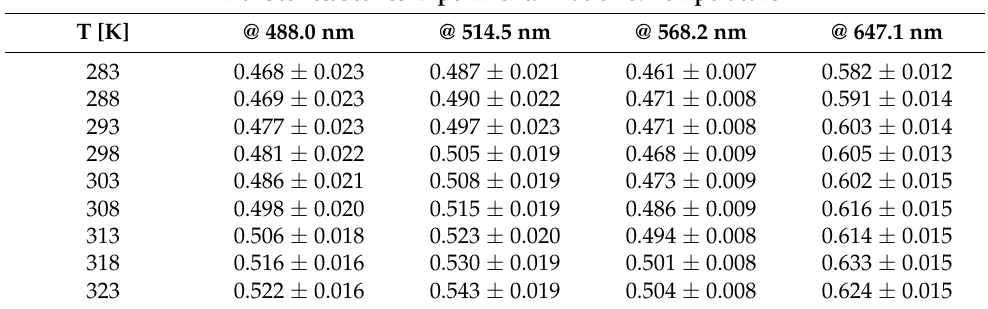
Table 4. Anti-Stokes/Stokes experimental ratios at different excitation wavelengths, as function of the temperature imposed by the thermostat.